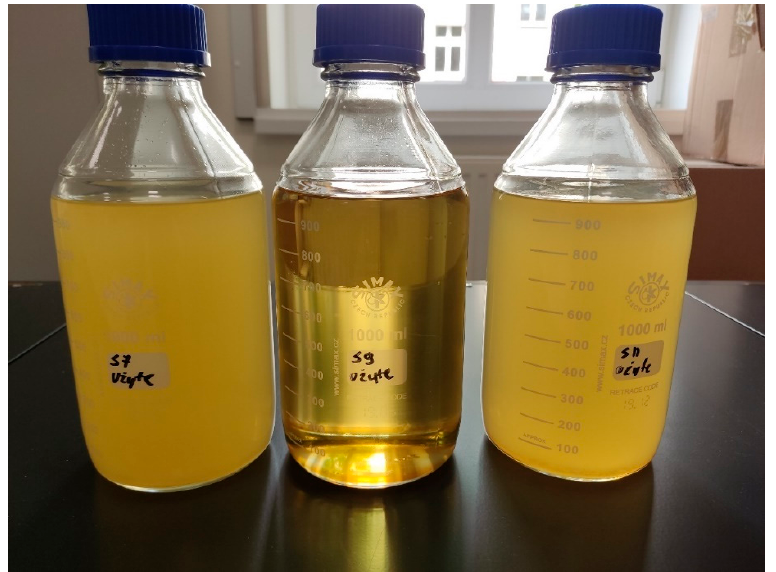
Figure 25. Post hoc Bonferroni test of Kruskal-Wallis test for all samples.